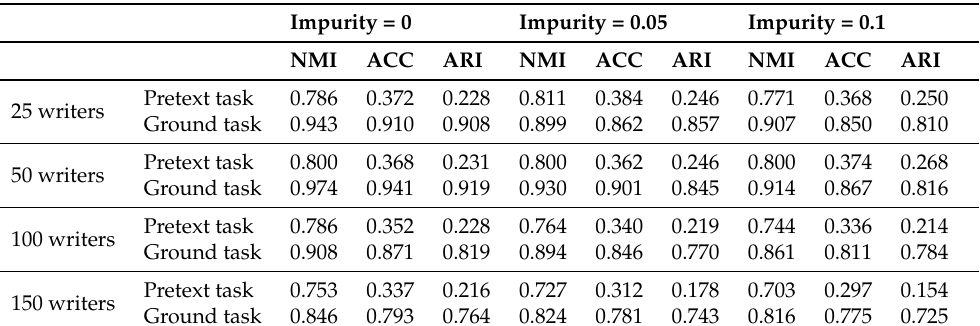
Table 4. The table illustrates the pairwise architecture in the CVL dataset across four-speaker groups: 25, 50, 100, and 150. The table also analyzes two segmentation impurities, 0 and 0.1, for each group of writers to illustrate the shortcomings of the faulty